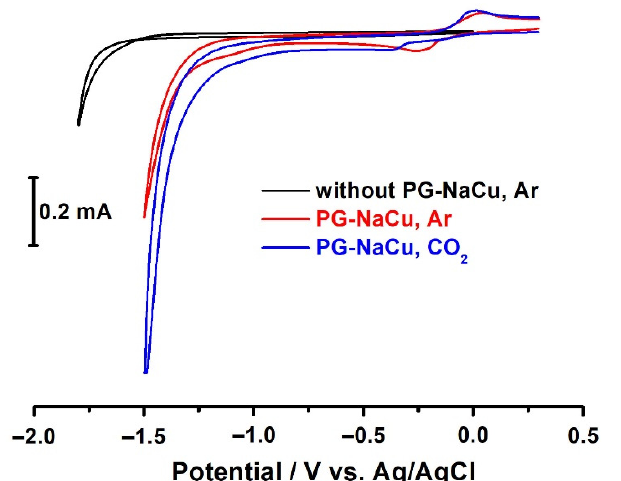
Figure 8. CVs recorded at a carbon-paste electrode (CPE) with the PG-NaCu complex when bubbling argon (red curve) or carbon dioxide (blue curve) through the H 2 O solution, 0.1 V/s. Black line is background at pure CPE.